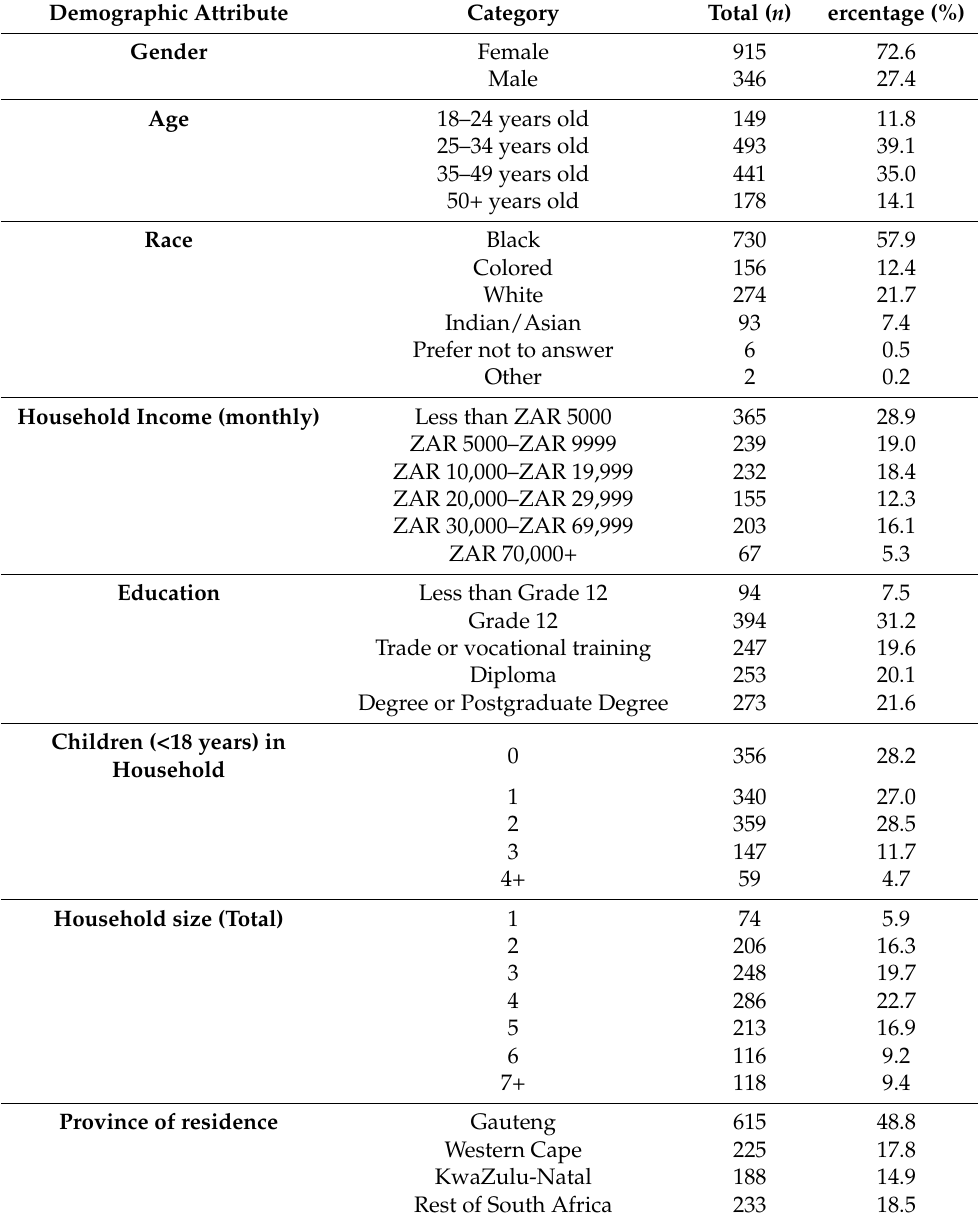
Table 1. Characterization of the consumer survey sample: Sociodemographic characteristics, self- reported health circumstances and food-shopping behavior ( n =